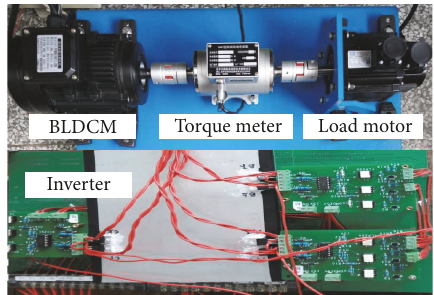
Figure 8: The configuration of experimental equipment.